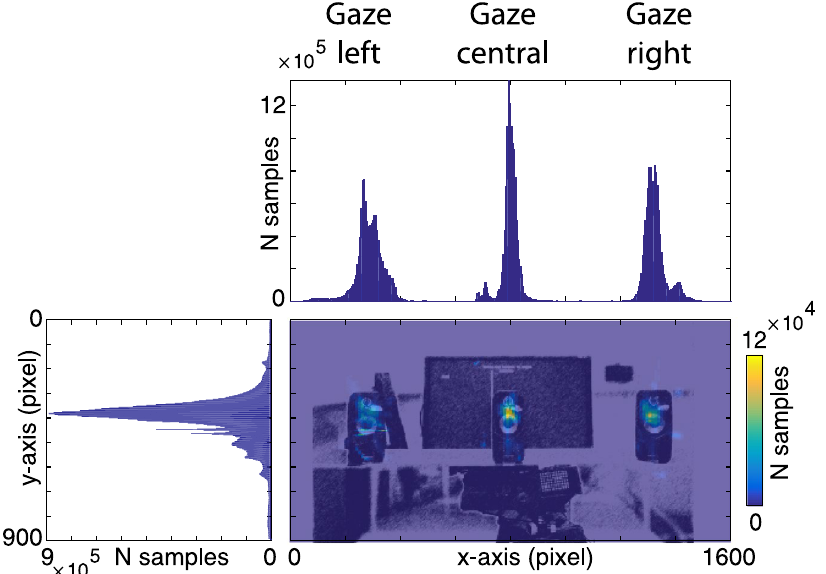
Figure 2. Eye-fixation data. Central plot: Heatmap of visual fixation duration, overlaid on the part of the visual field which contained the three loudspeakers. Heatmap and picture are corresponding in size. The data shown are pooled across all subjects and conditions. Warm colours indicate a large number of samples during which a point was fixated. Upper plot: Histogram showing the number of samples each point in the horizontal axis was fixated. Clear peaks for the left, central and right loudspeaker location are visible. Left plot: Histogram showing fixations for the vertical